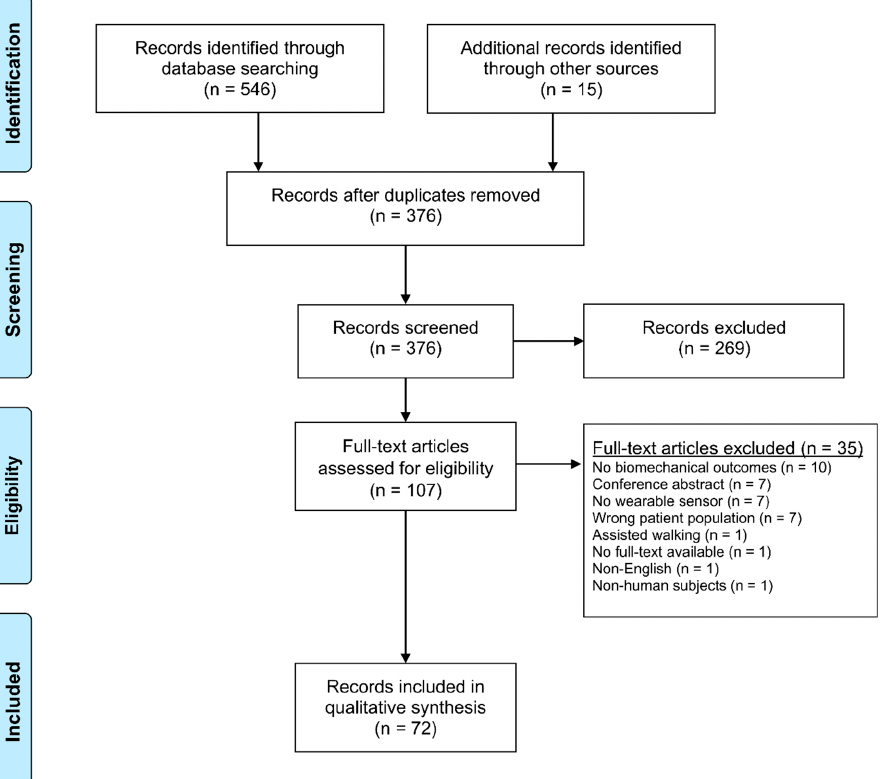
Figure 1. Preferred Reporting Items for Systematic Reviews and Meta-Analyses (PRISMA) flow Figure1.